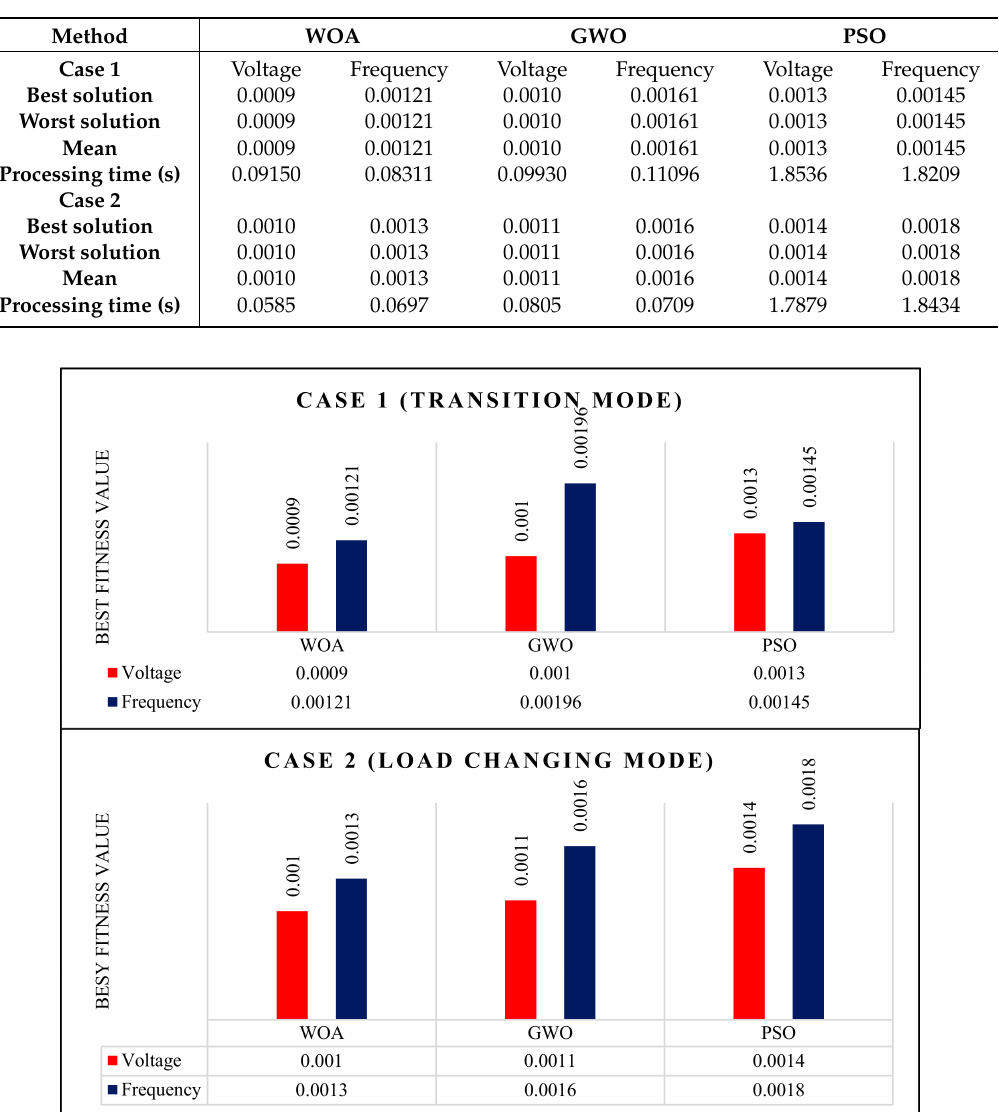
Table 4. Statistical performance of considered optimization techniques.